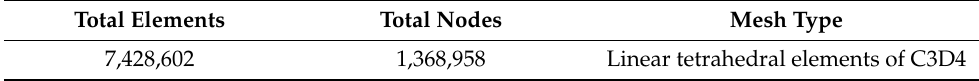
Table 3. Nodes and elements for tested groups.